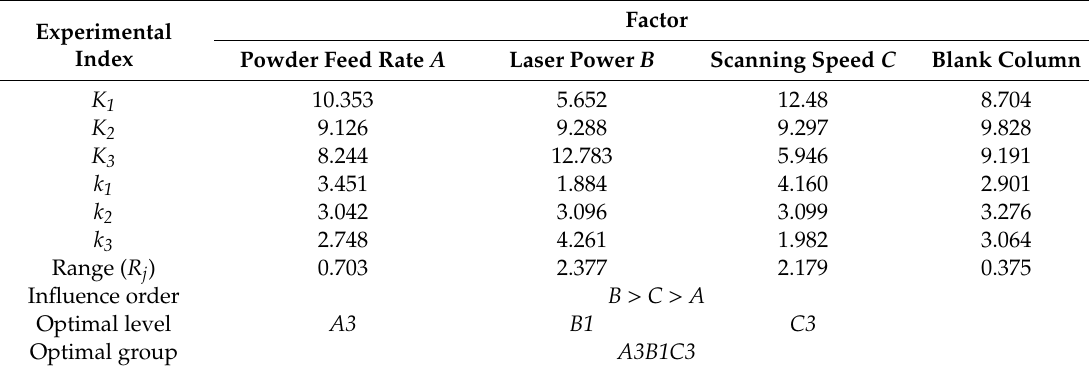
Table 6. The results of the range analysis of the sheet